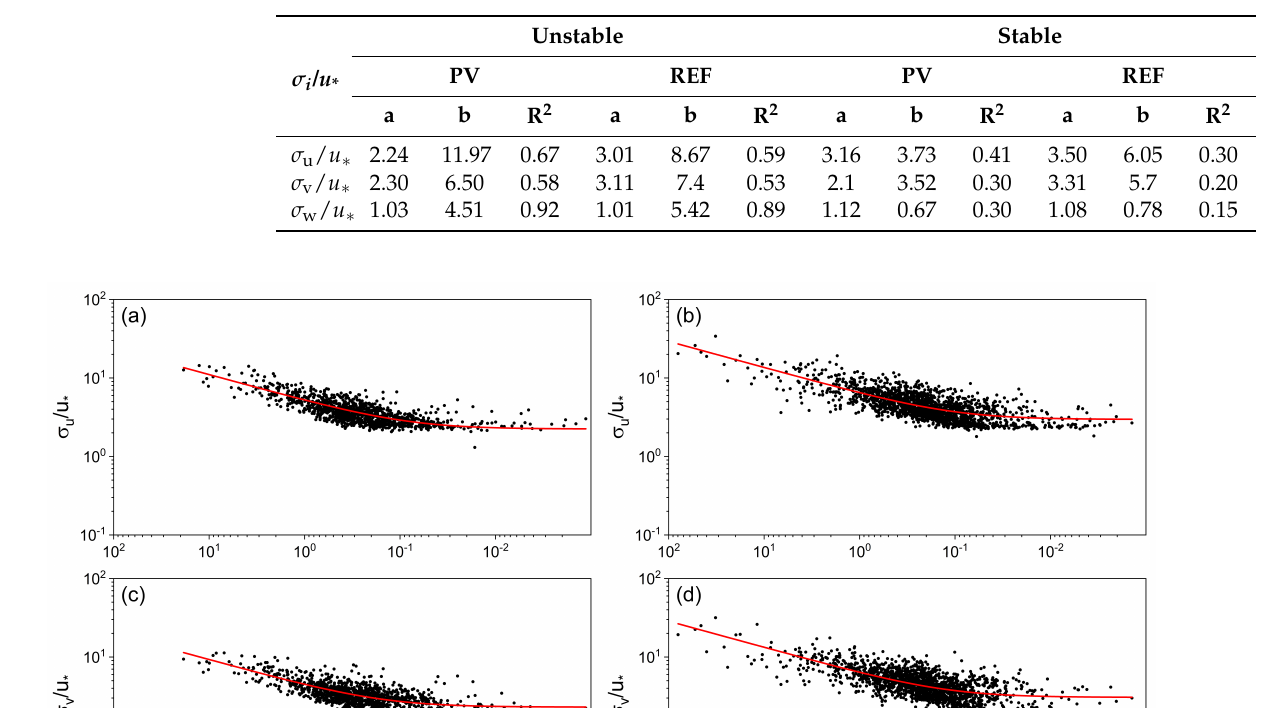
Table 1. Optimal similarity function coefficients for fitting normalized standard deviation of lon- unstable and stable stratification conditions for the observed data from June to October 2019.